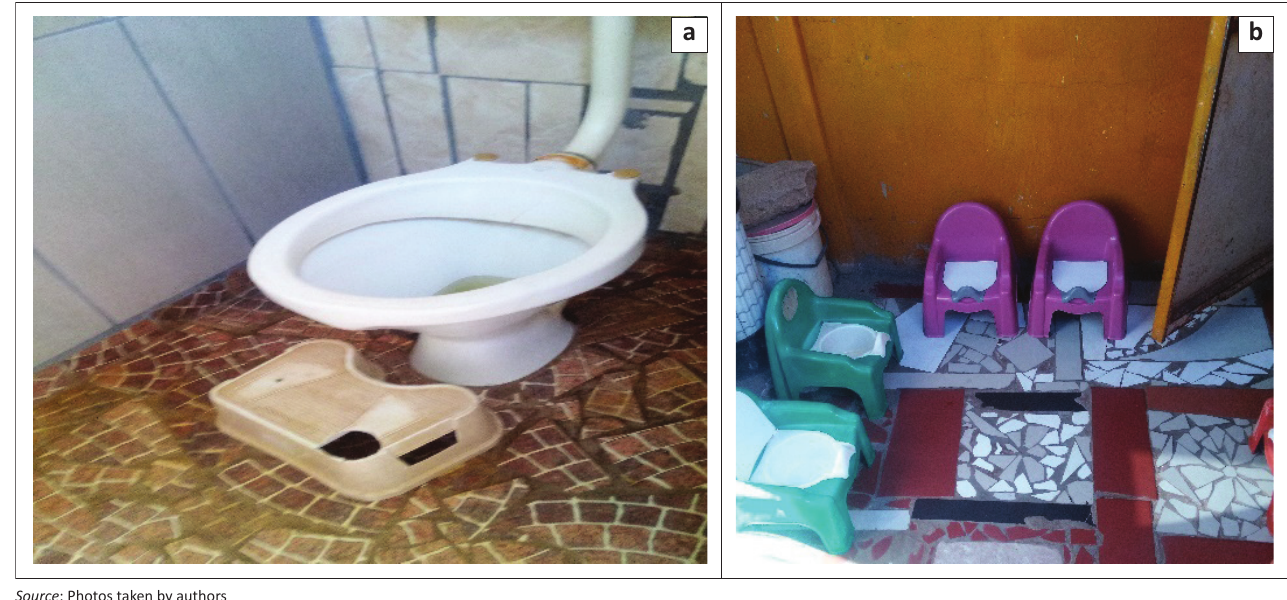
FIGURE 2: Photos (a-b) of township centre A’s toilet facilities.